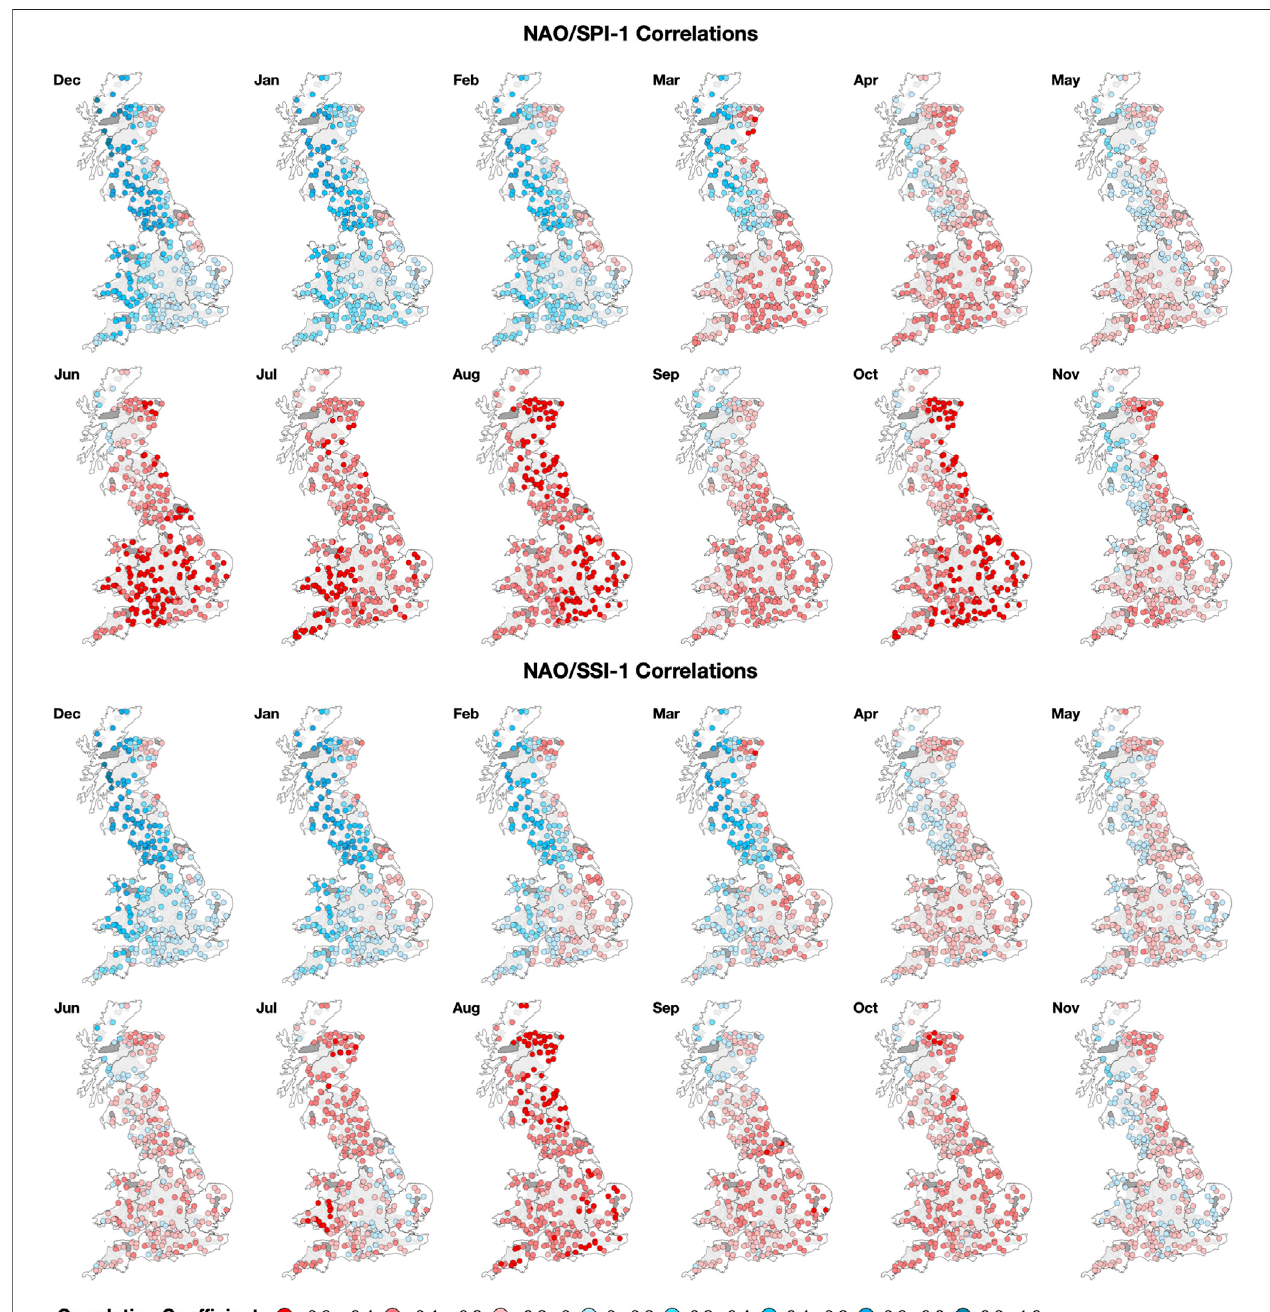
FIGURE 2 | Monthly correlations between the NAO and SPI-1/SSI-1 for the 291 catchments across Great Britain. Note the difference between the signi fi cant positive correlations in the NW during winter (DJF), compared to the more spatially homogenous negative correlations in summer (JJA).